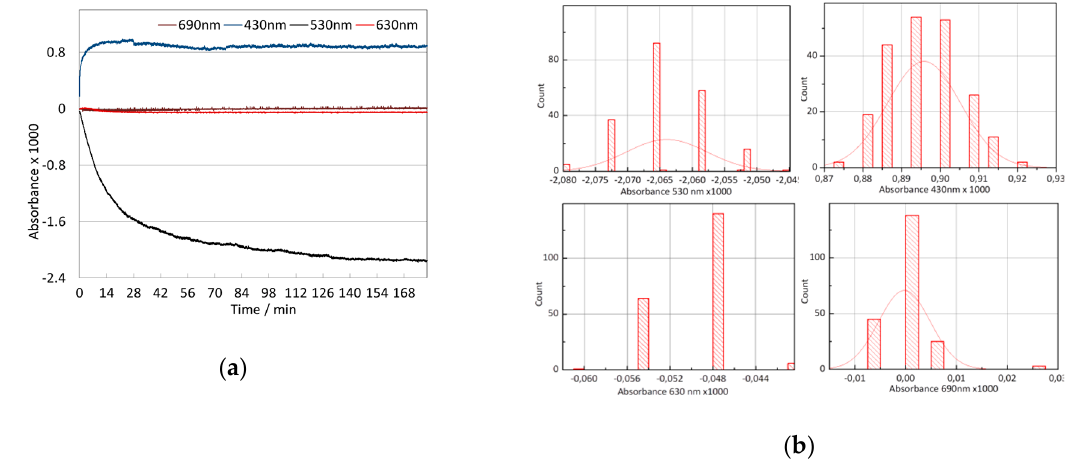
Figure 3. Characterization of the signal stability and measurements: ( a ) stability of the optical signal of various LEDs of different wavelength over a time of 3 h; ( b ) histogram plots of the short-term noise. Inordertotestthe suitabilityofthechosenapproachofa 2-LED- µ